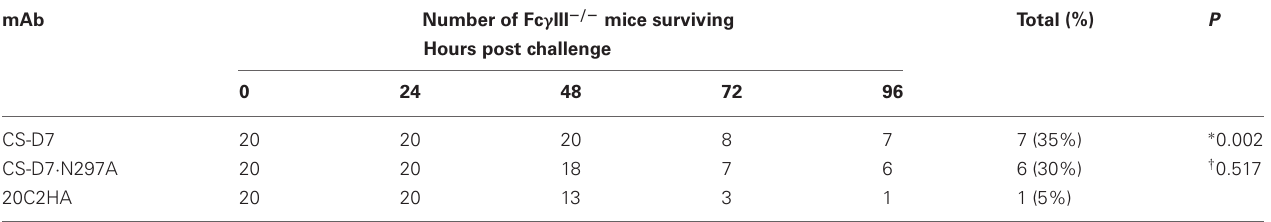
∗ Comparison of survival with CS-D7 versus survival with isotype control 20C2HA. † Comparison of survival with CS-D7 · N297A versus survival with CS-D7. Table 4 | Passive immunization and challenge of Fc γ II − / − mice. mAb